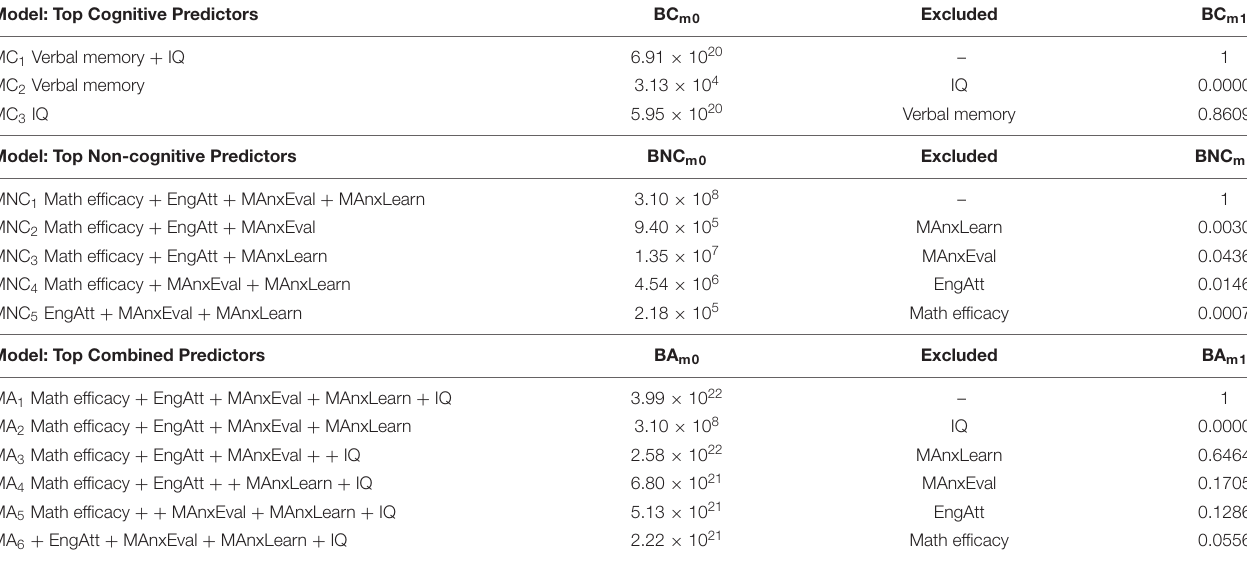
TABLE 7 | Bayes factor analyses of predictors of in-class attentive behavior. Model: Top Cognitive